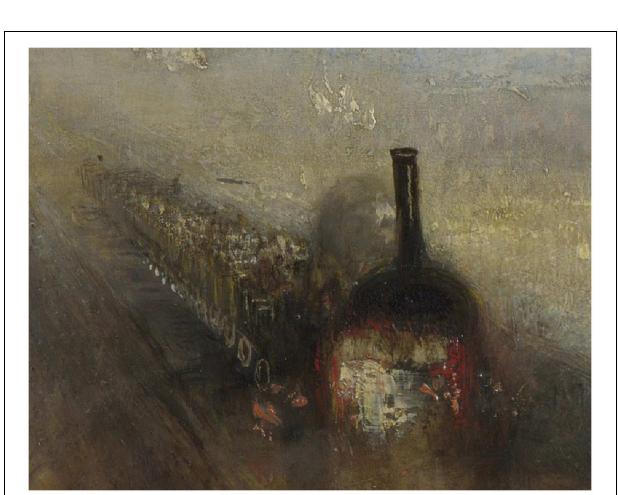
FIGURE 3 | Detail from Joseph Mallord William Turner, Rain, Steam, Speed: The Great Western Railway . © The National Gallery,